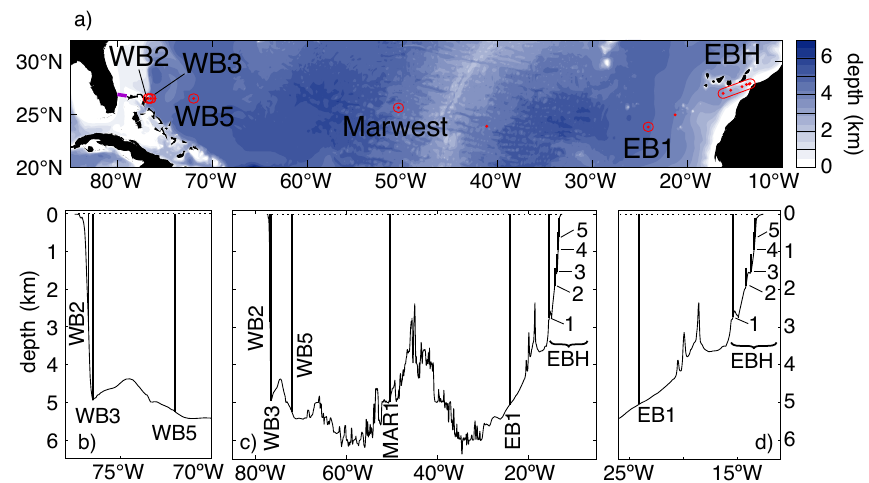
Fig. 1. Mooring locations. (a) Chart of the Atlantic showing all Rapid/MOCHA moorings (red dots), the 6 moorings used here (circled), and the Florida Current cable (purple line). Cross-section of the transect for the (b) western boundary, (c) full transect, and (d) eastern boundary. The eastern boundary slope moorings (EBH1–EBH5) are shown for the deployment in 2004. Bathymetry comes from ETOPO5.